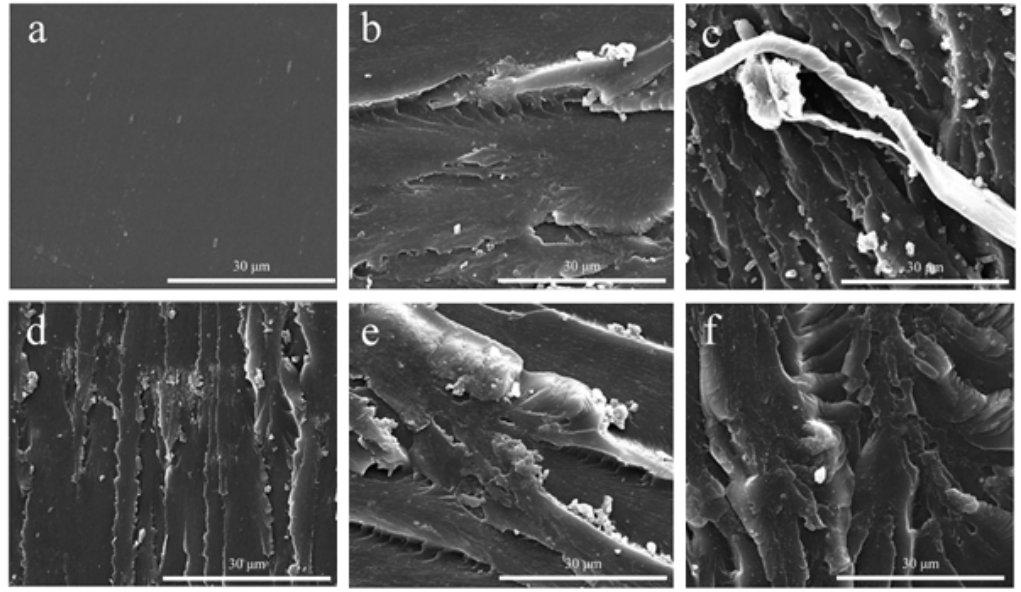
Figure 12. SEM images of the fracture of pure epoxy and its nanocomposite filled by PABA-modified MWCNTs: ( a ) pure epoxy resin; and ( b ) 0.2, ( c ) 0.4, ( d ) 0.6, ( e ) 0.8, and ( f ) 1.0 wt %.